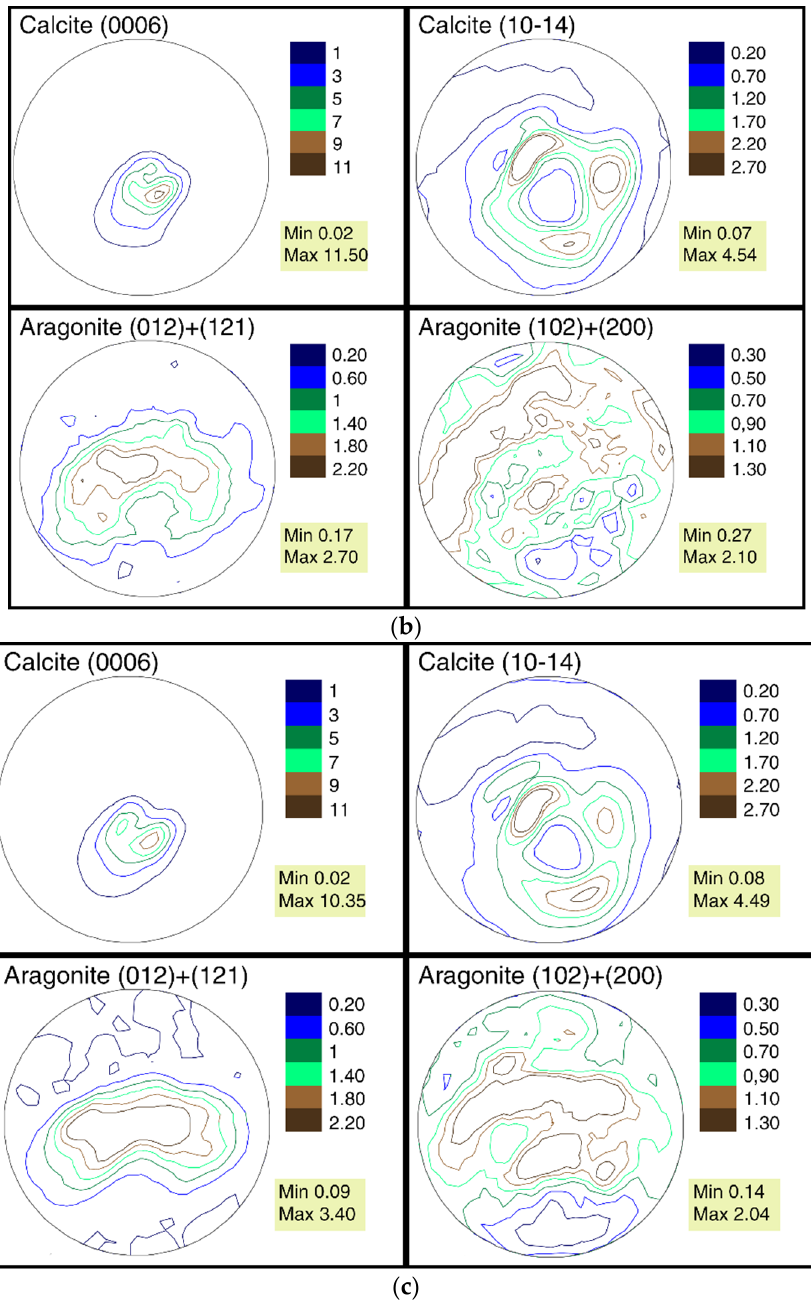
Figure 3. ( a ) The pole figures of calcite and aragonite phases for mussel shells from station 1 (Danger Bay). ( b ) The pole figures of calcite and aragonite phases for mussel shells from station 2 (Langebaan). ( c ) The pole figures of calcite and aragonite phases for mussel shells from station 3 (Small Bay).